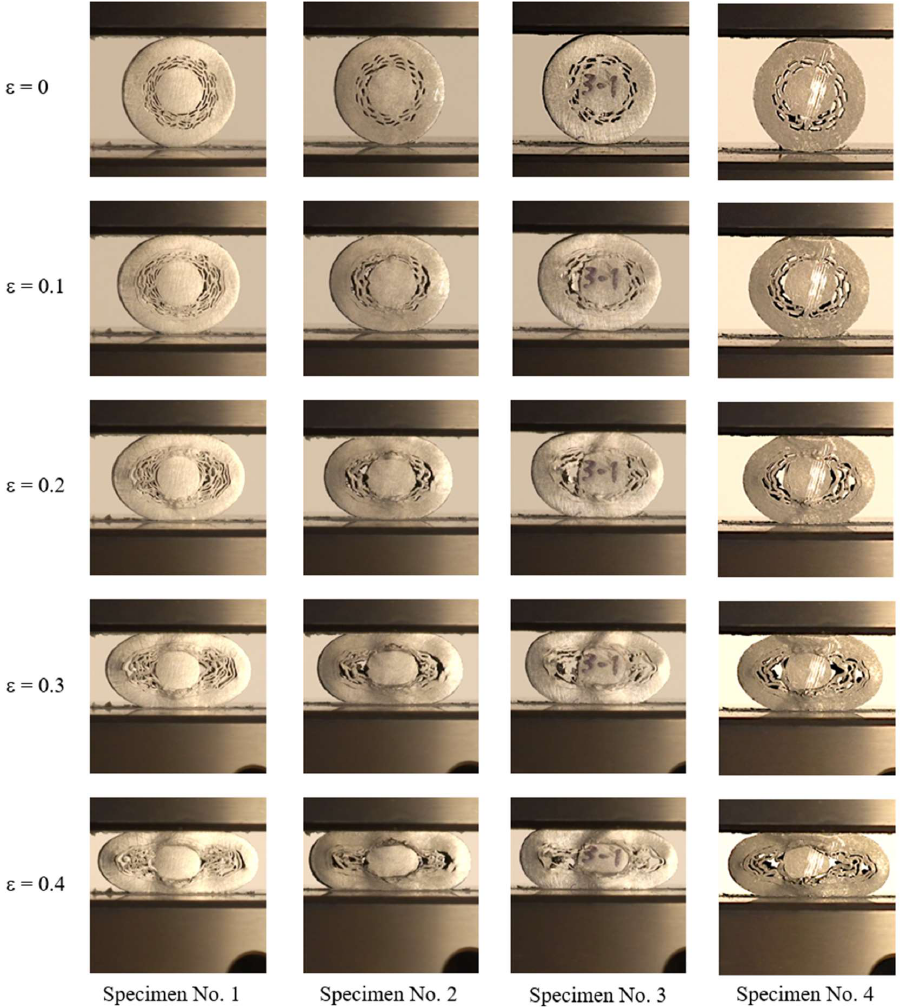
Figure 9. Transversal compressive testing of rolled aluminium UniPore structure.